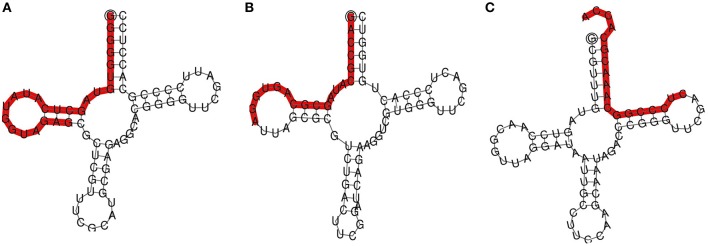
TRNA derived small RNAs cloned from black pepper: (A) 5′AlaCGC tRF and (B) 5′ArgTCG tRF, and (C) 3′GlyTCC tRF. TRFs were highlighted on the secondary structures of the mature tRNA.